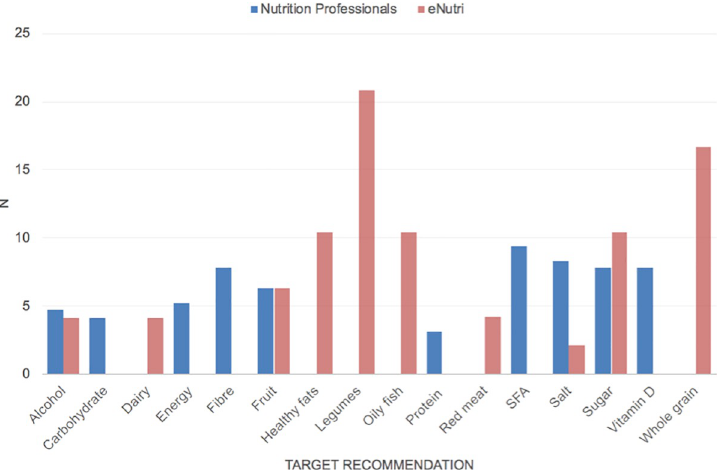
Fig 4. Number of times each target recommendation was selected by nutrition professionals and by the eNutri app for all scenarios